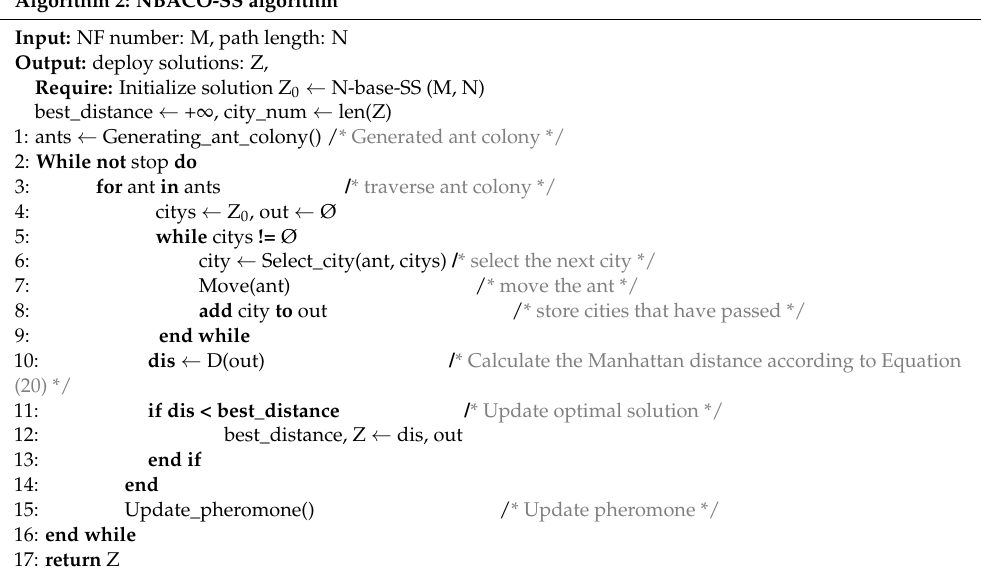
Algorithm 2: NBACO-SS